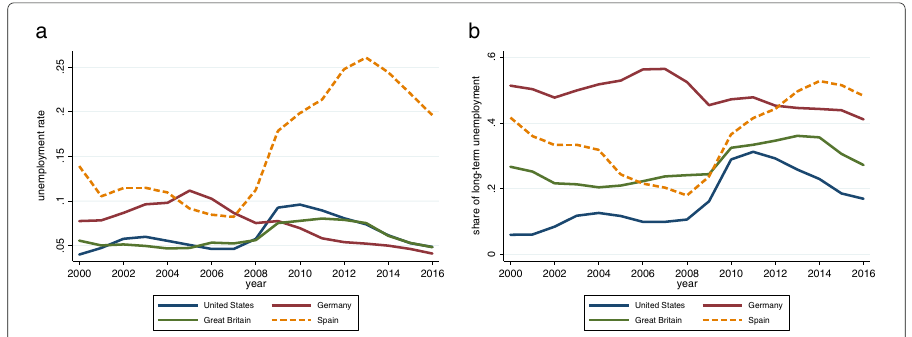
Fig. 2 Comparison of unemployment in Spain and other OECD countries. a Unemployment rate, b Share of long-term unemployment (people who have been unemployed for 12 months or more). Note: Data is from the OECD unemployment